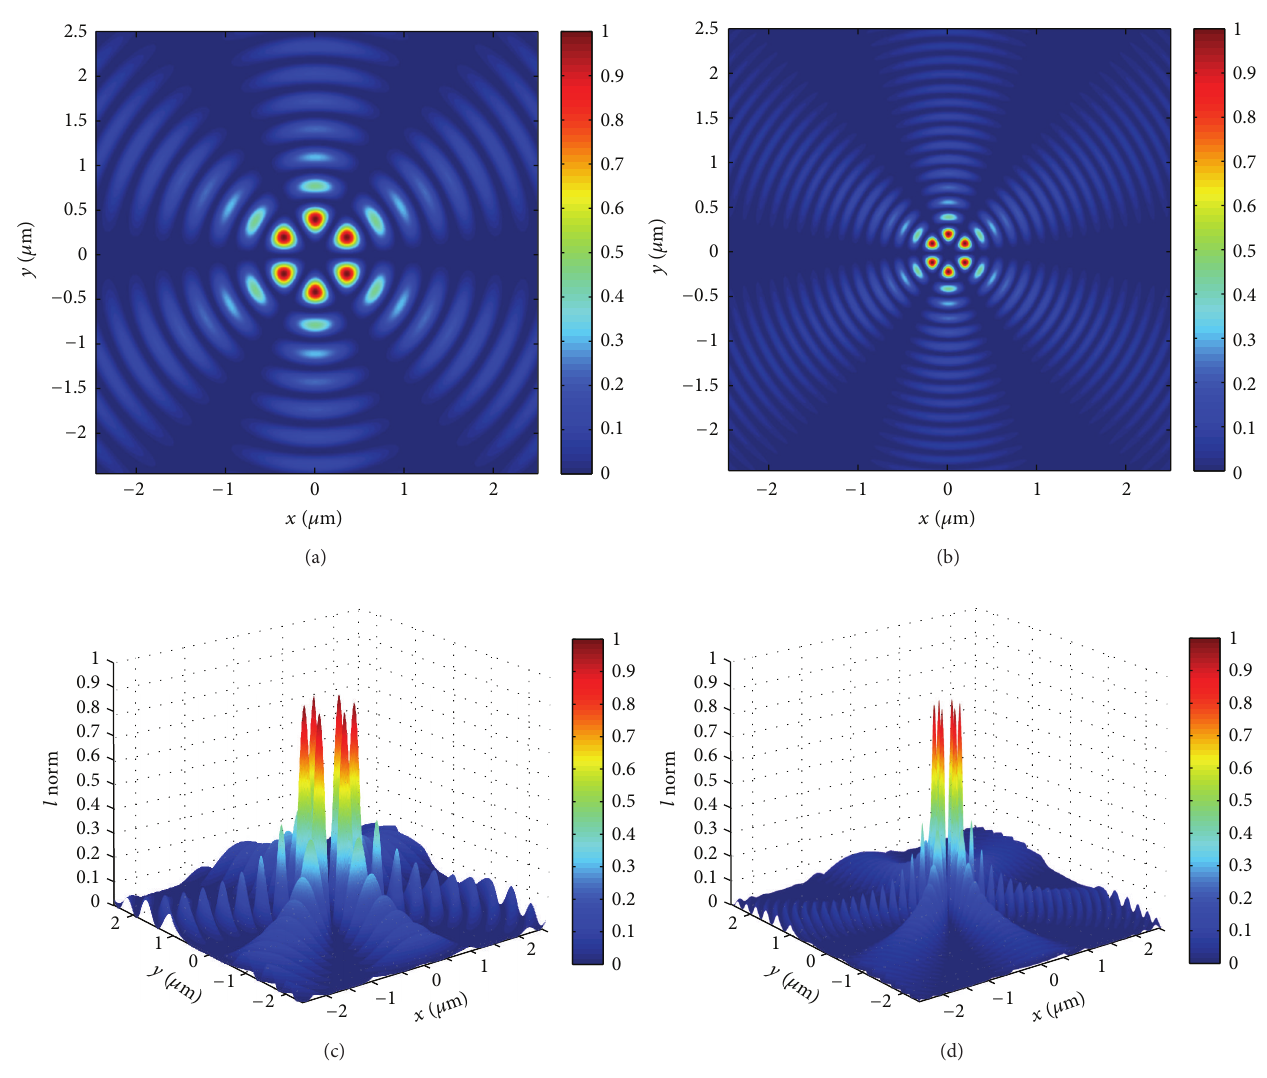
2 max of Bessel multiplasmon in the air at the distance 𝜆 = 0.633 𝜇